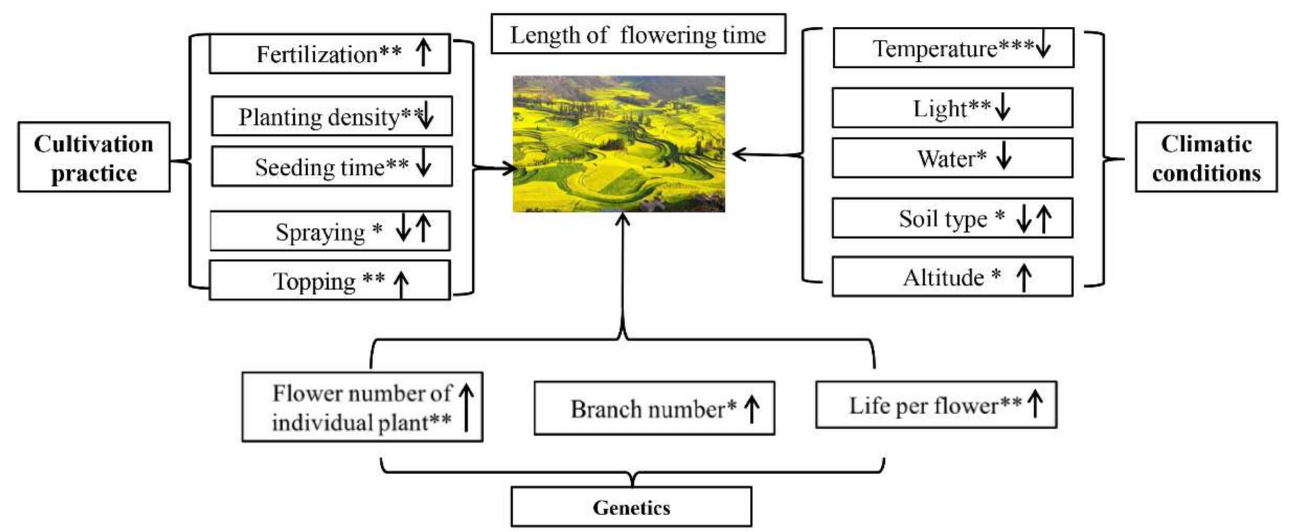
Figure 1. Summary of the factors affecting the length of the rapeseed flowering period. * represents the mild degree of importance, ** represents the moderate degree of importance, *** represents the severe degree of importance. Vertical up “ ↑ ” and down arrows “ ↓ ” represent positive and negative effects,